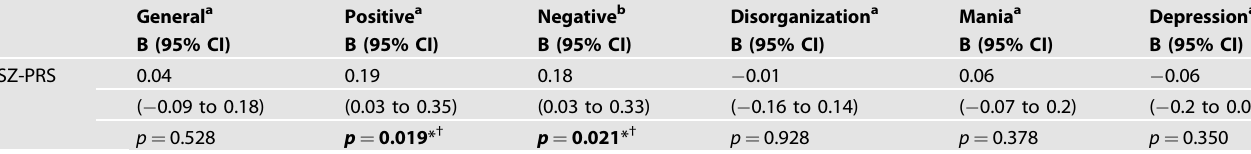
Table 2. Symptom dimension scores by SZ-PRS in cases. General a Positive